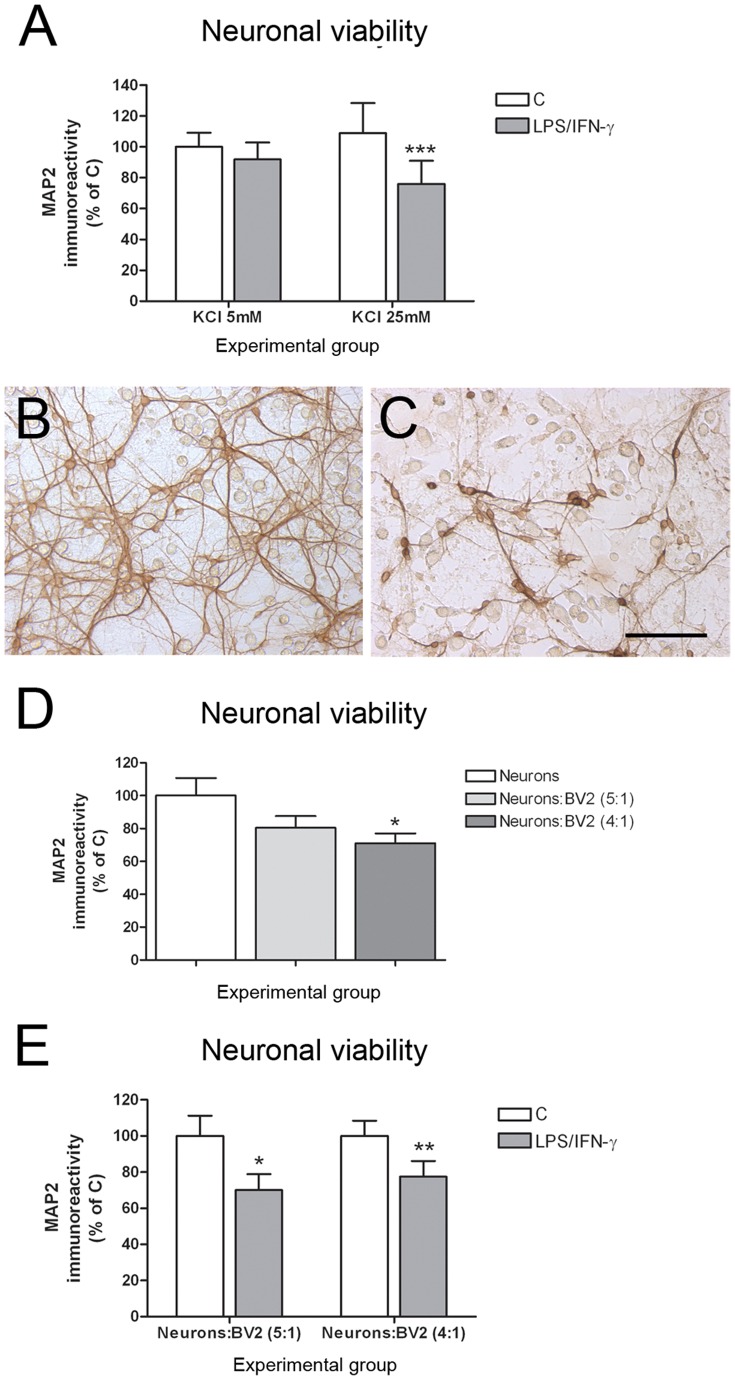
Increased extracellular K+ concentration enhanced reactive glia-induced.neurotoxicity in neuron-BV2 co-cultures. (A) Neuronal viability (MAP2-ABTS-ELISA assay) in neuron-BV2 co-cultures grown in 5 mM and 25 mM KCl 24 h after 100 ng/mL LPS +0.5 ng/mL IFN-γ treatment. Results are presented as % of MAP2 immunostaining in control co-cultures grown in 5 mM KCl. Bars are means + SEM of four independent experiments. ***p<0.001 vs respective control; two-way ANOVA (repeated measures) and Bonferroni post-test. (B) MAP2 immunostaining in control (B) and 100 ng/mL LPS +0.5 ng/mL IFN-γ treated co-cultures grown in high K+. Bar = 100 µm. (D) Increasing BV2:neuron ratio results in neurotoxicity in control neuron-BV2 co-cultures. (E) Increasing BV2:neuron ratio does not result in increased neurotoxicity in 100 ng/mL LPS +0.5 ng/mL IFN-γ treated co-cultures.